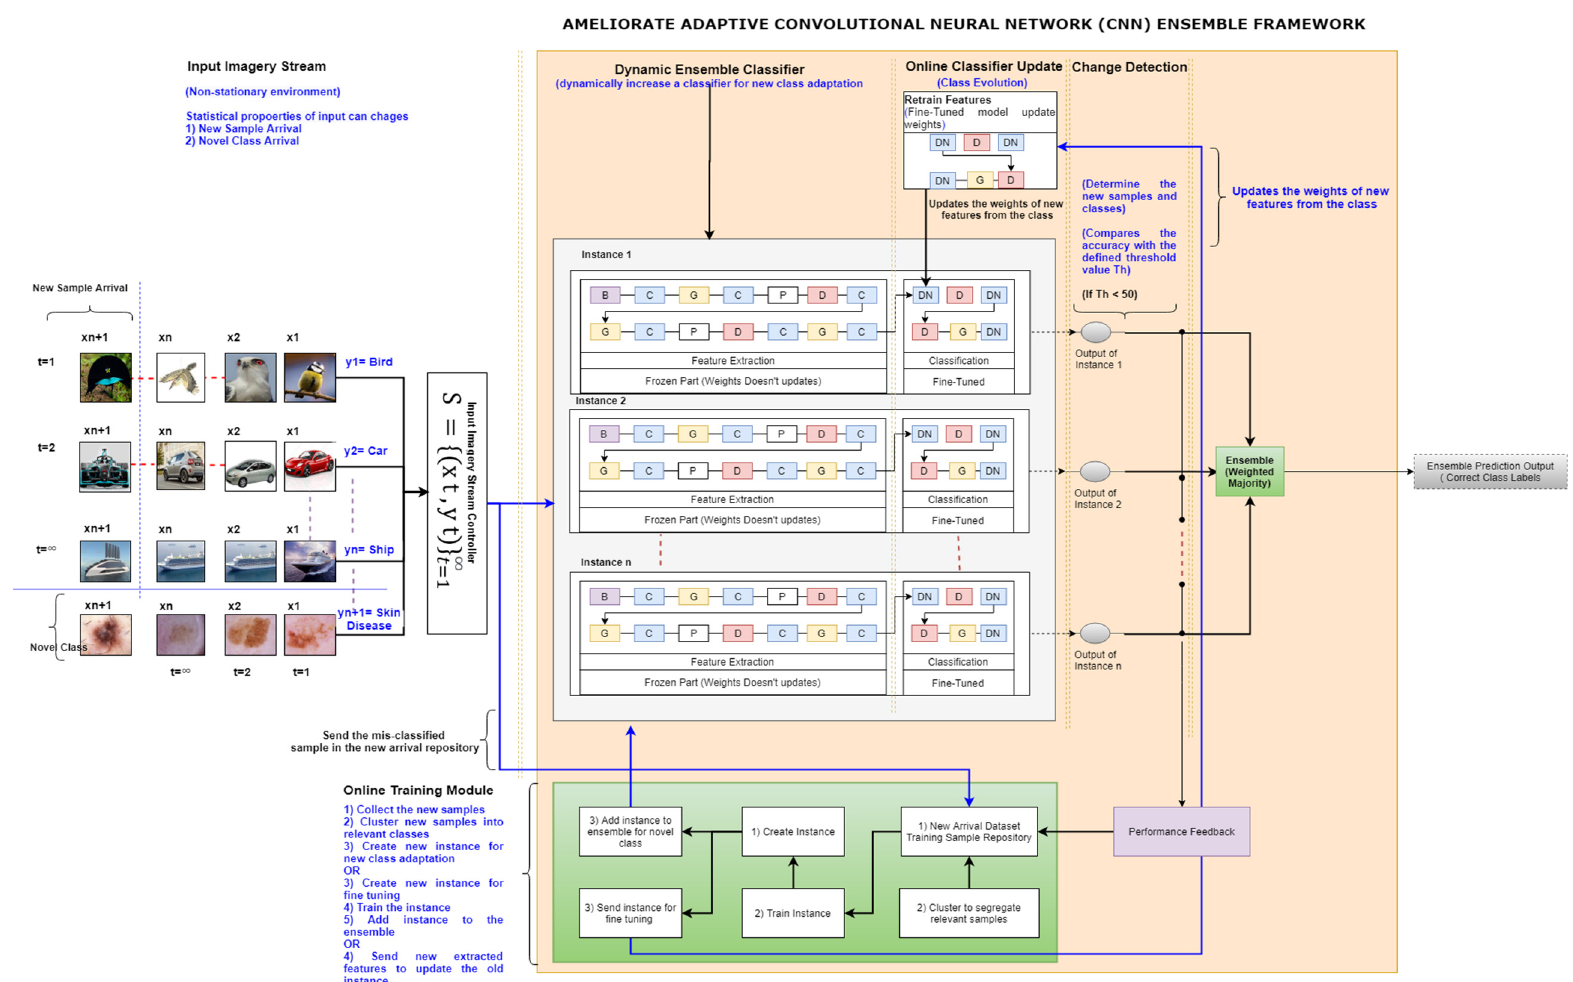
Figure 1. Ameliorated Adaptive Convolutional Neural Network (CNN) Ensemble framework to handle novel class and class evolution.